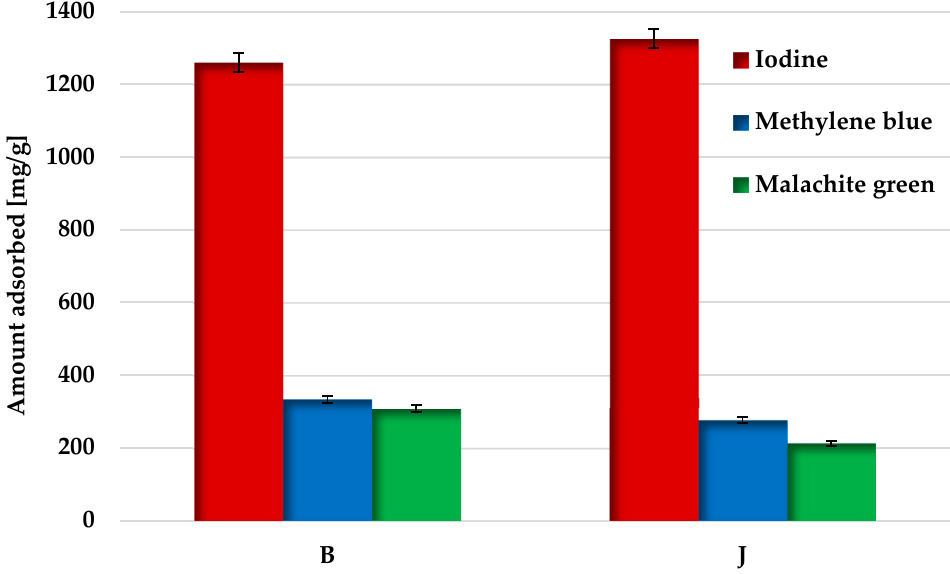
Figure 5. Adsorption capacity of carbonaceous materials towards iodine, methylene blue, and malachite green.